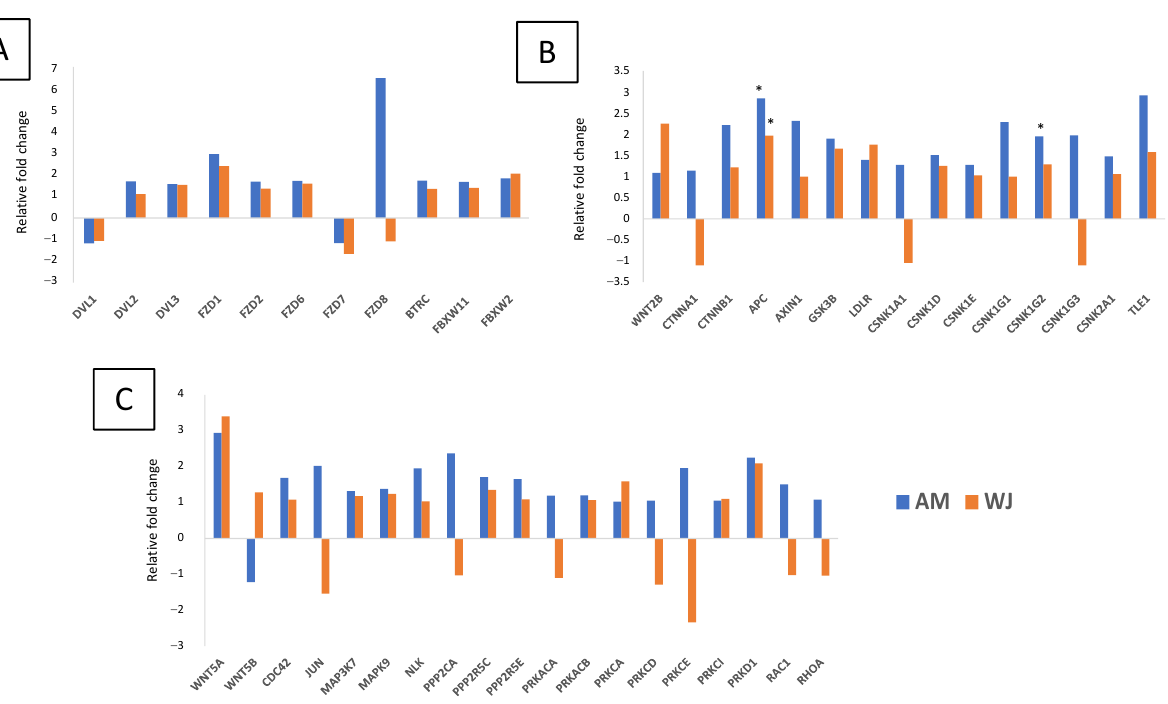
Figure 7. Differential expression of genes associated with Wnt signalling pathways in AM- and WJ-MSCs during osteogenesis. ( A ) Receptors, ubiquitin ligases, ( B ) canonical pathway and ( C ) non-canonical pathway. Asterisks (*) represent statistical significance p < 0.05.